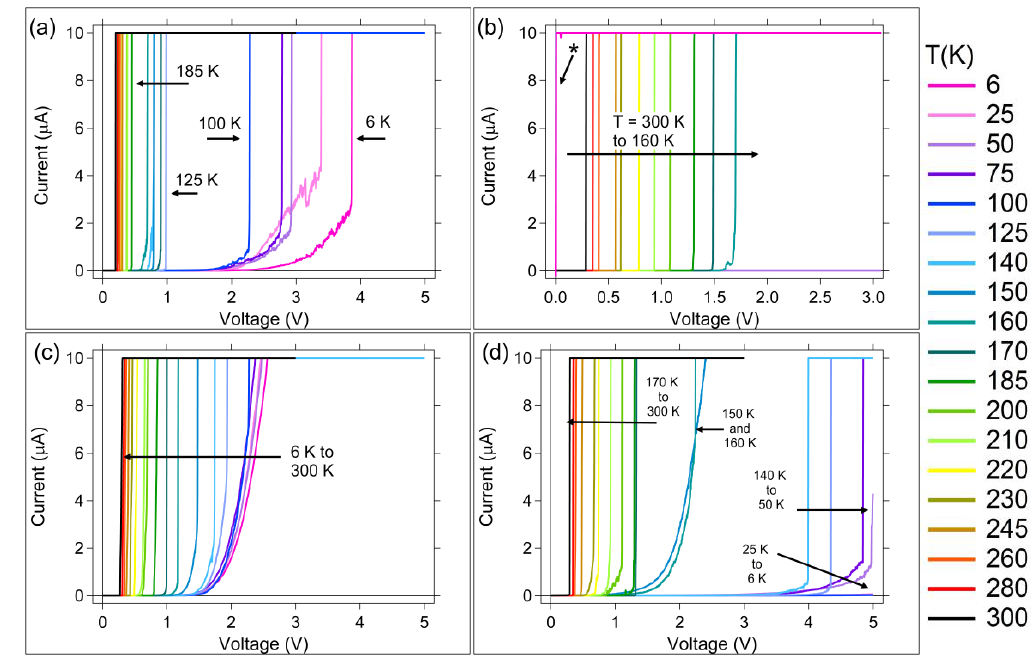
Figure 2. Representative Write I–V curves as a function of temperature. Ag devices: ( a ) Write 1; ( b ) Write 2. Cu devices: ( c ) Write 1; ( d ) Write 2. The * in (b) corresponds to I–V curves of broken (shorted) devices. Note: the Write 1 sweep voltage maximum for measurements below 150 K was 5 V, compared to 3 V used for T ≥ 150 K.